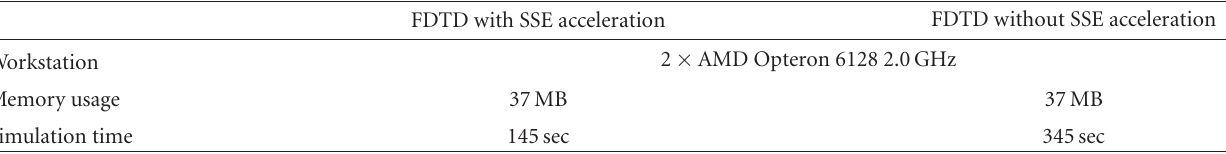
Table 1: Parallel FDTD performance with the SEE acceleration.